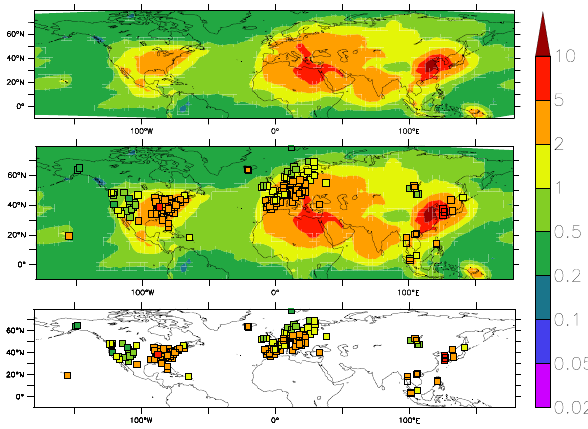
Fig.9. (a) Toppanel: Simulatedannualmeanconcentrationofsulfateaerosol(µg(SO 42 − )m − 3 )fortheyear2001. (b) Sameas(a)butwith observations from the CASTNET, EMEP and EANET networks over-plotted. Panel (c) shows the observations alone. Fig. 9. (a) Top panel: simulated annual mean concentration of sul- fate aerosol (µg (SO 42 − )m − 3 ) for the year 2001. (b) Same as (a) but with observations from the CASTNET, EMEP and EANET net- works over-plotted. Panel (c) shows the observations alone.